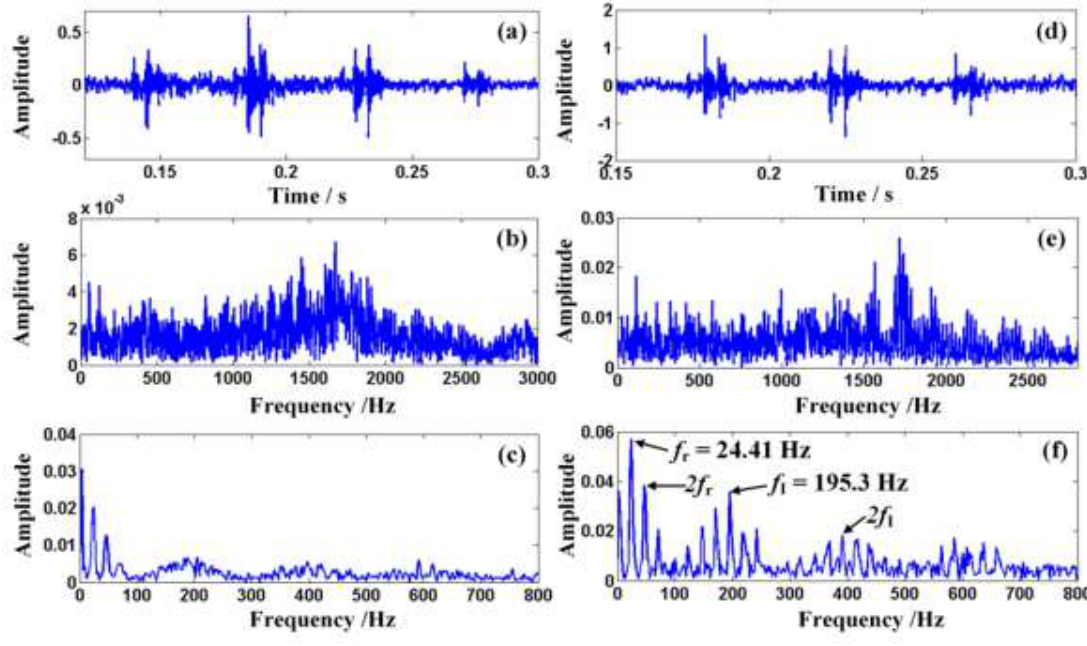
Figure 15. ( a – c ) The waveform, the spectrum and the envelope of the Doppler distorted signal emitted by the fault bearing with inner-race defect; ( d – f ) the waveform, the spectrum and the envelope spectrum of the restored signal.